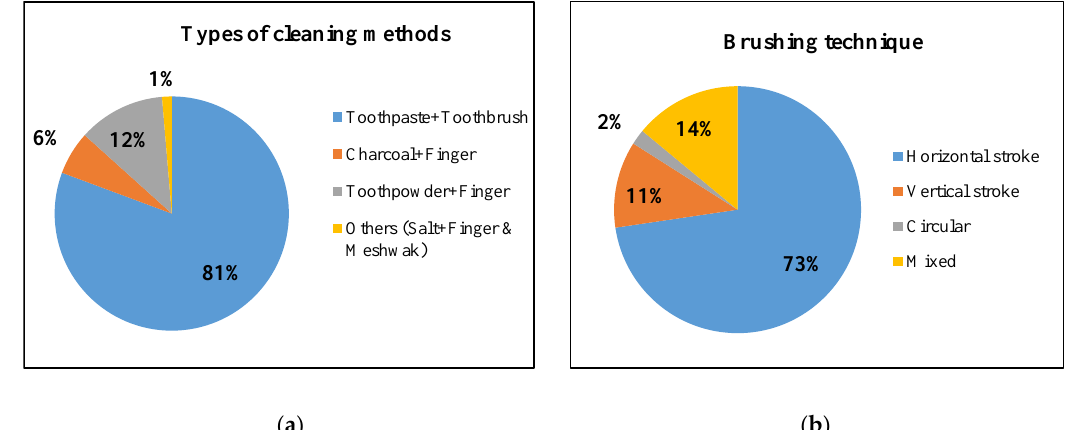
Figure 1. ( a ) Method used to clean the teeth; ( b ) brushing techniques used by students.